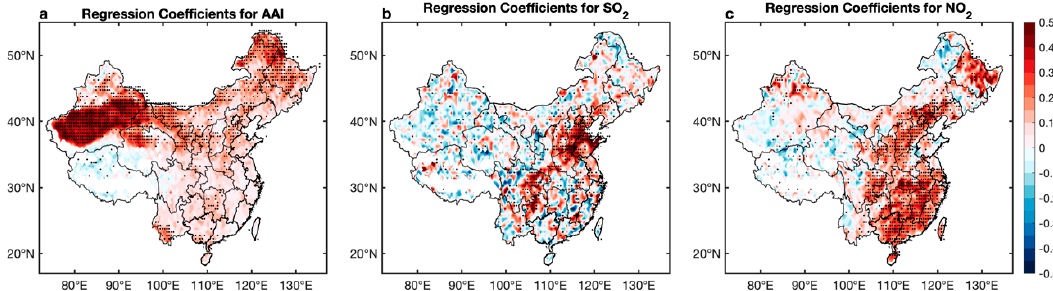
Figure 12. Regression coefficients for AAI ( a ), SO 2 ( b ), and NO 2 ( c ) for the multiple regression model. Each individual coefficient was tested using the F test and places passing the 95% significance level are marked by black dots.